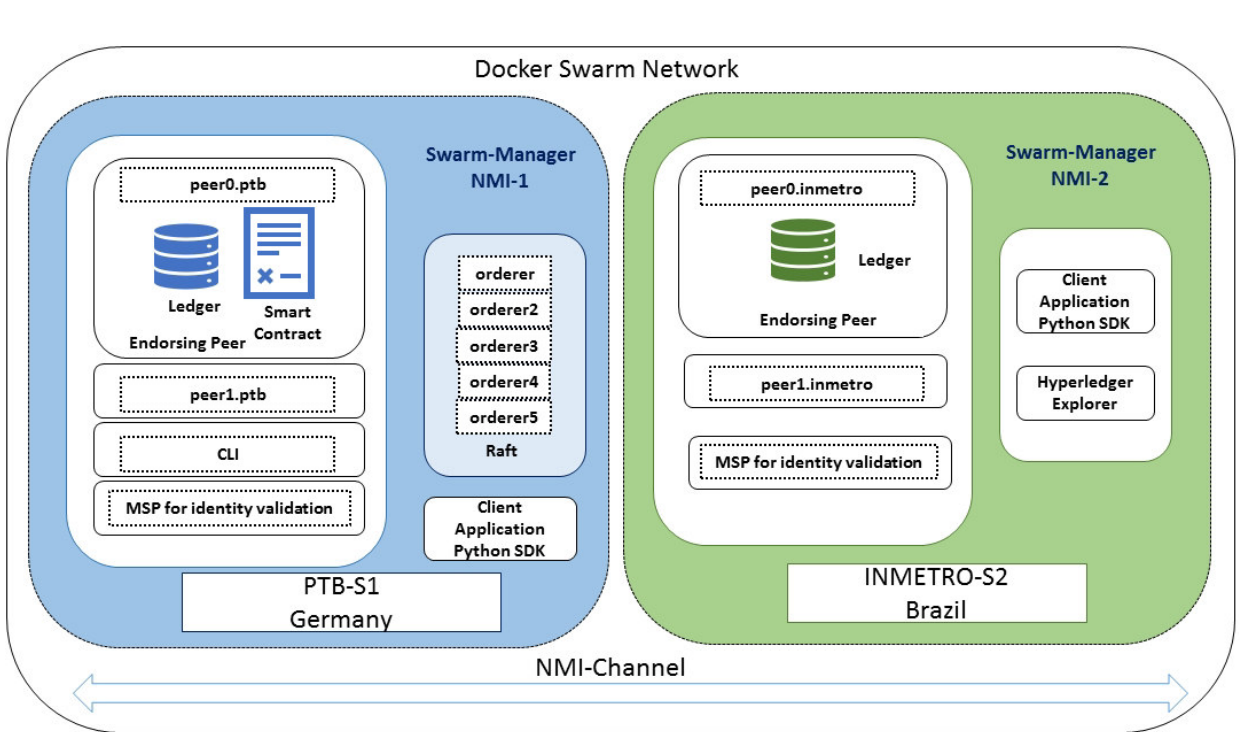
Figure 4. Docker swarm-based inter-NMI blockchain network. MSP, Membership Service